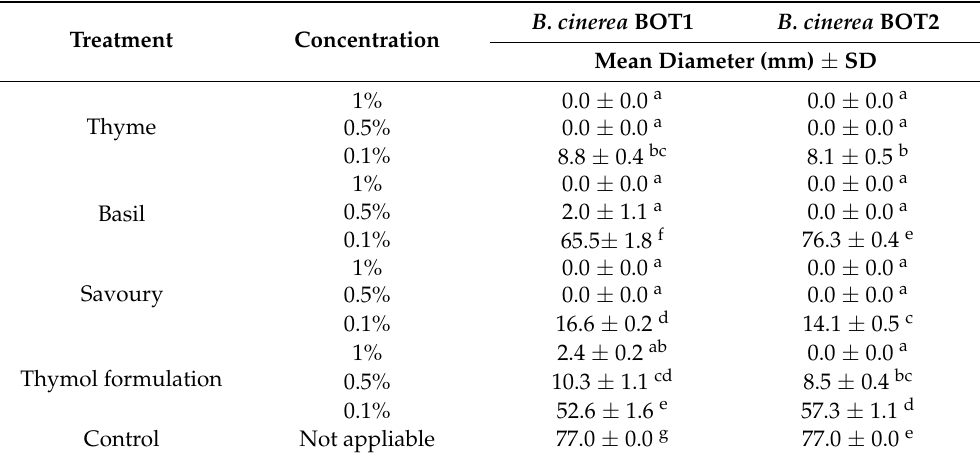
Table 1. Effect of volatiles released by EOs on mycelial growth (diameter, cm) of two strains of B. cinerea in sandwich plate